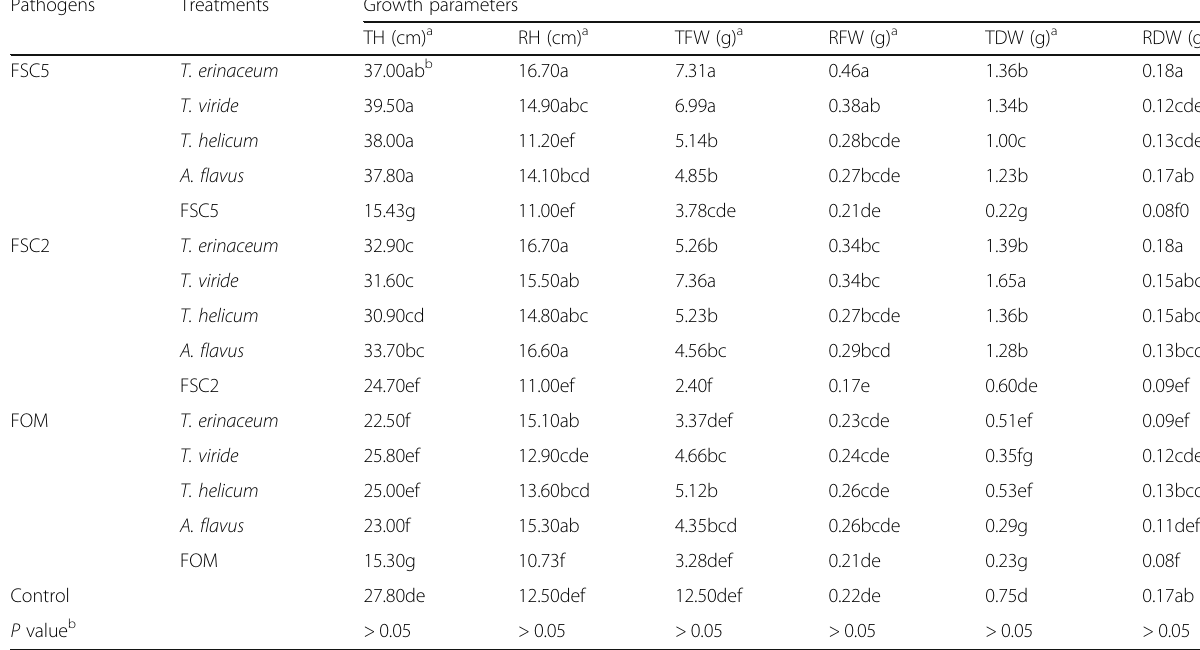
Table 10 Comparison of different growth parameters values: shoot and root heights (cm), shoot and root fresh weights (g), and shoot of root dry weights (g) recorded by melon seedlings inoculated by two F. solani f. sp. cucurbitae isolates (FSC 5 and FSC 2) and two F. oxysporum f. sp. melonis isolates (FOM) and treated curatively by three Trichoderma spp. isolates and A. flavus Pathogens